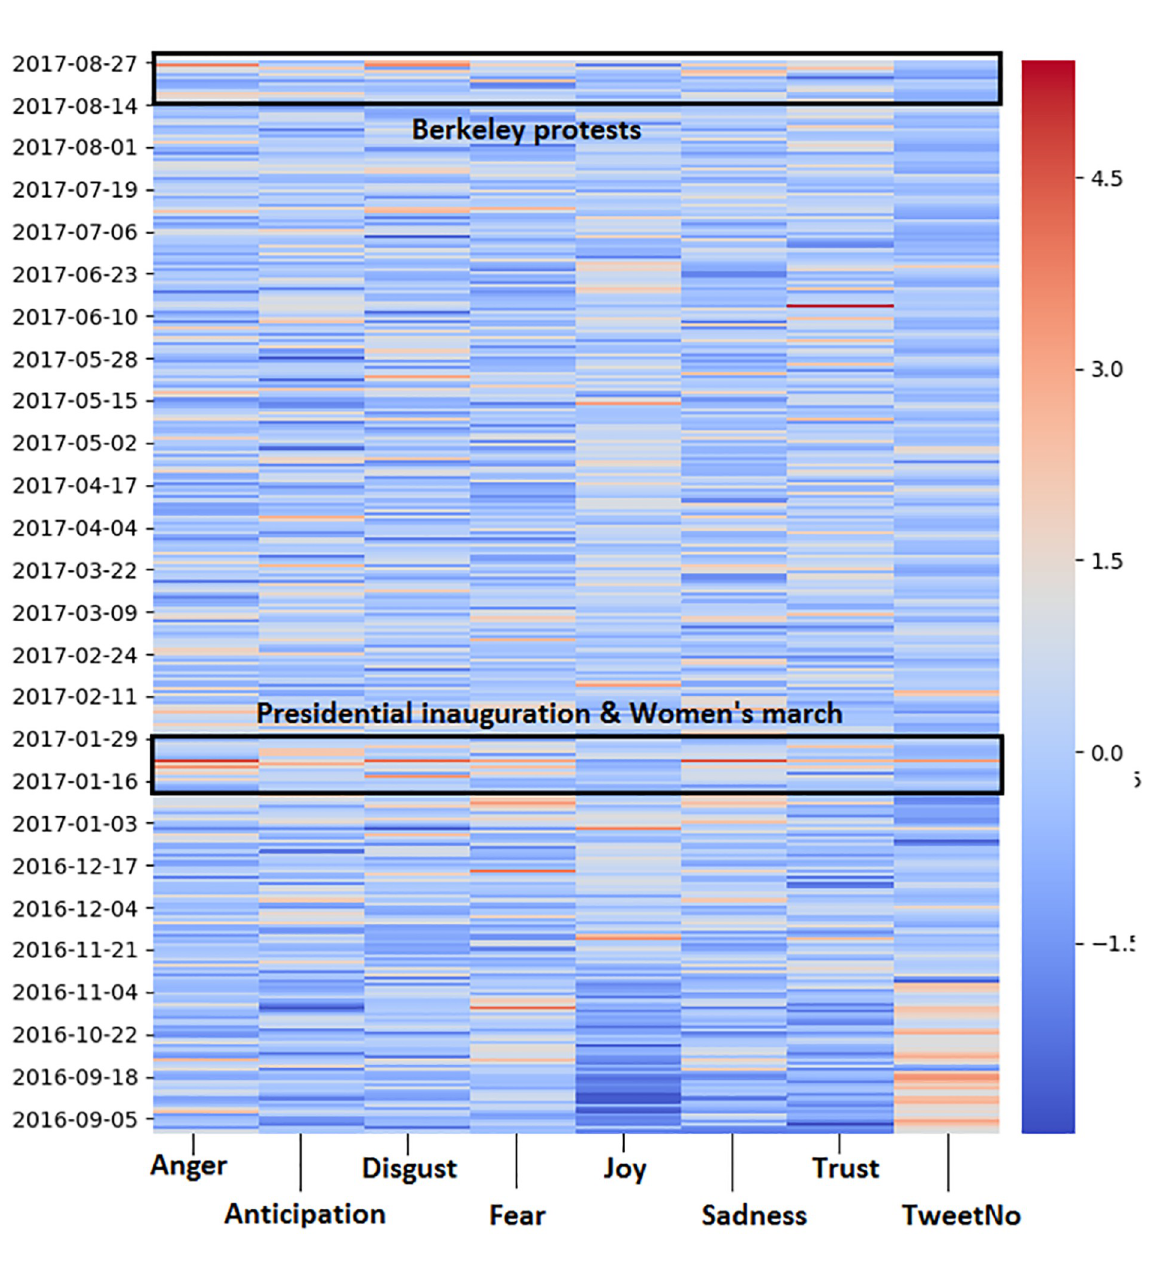
Fig 3. A time based heatmap of San Francisco (red = high levels of emotion, blue = low levels of emotion).